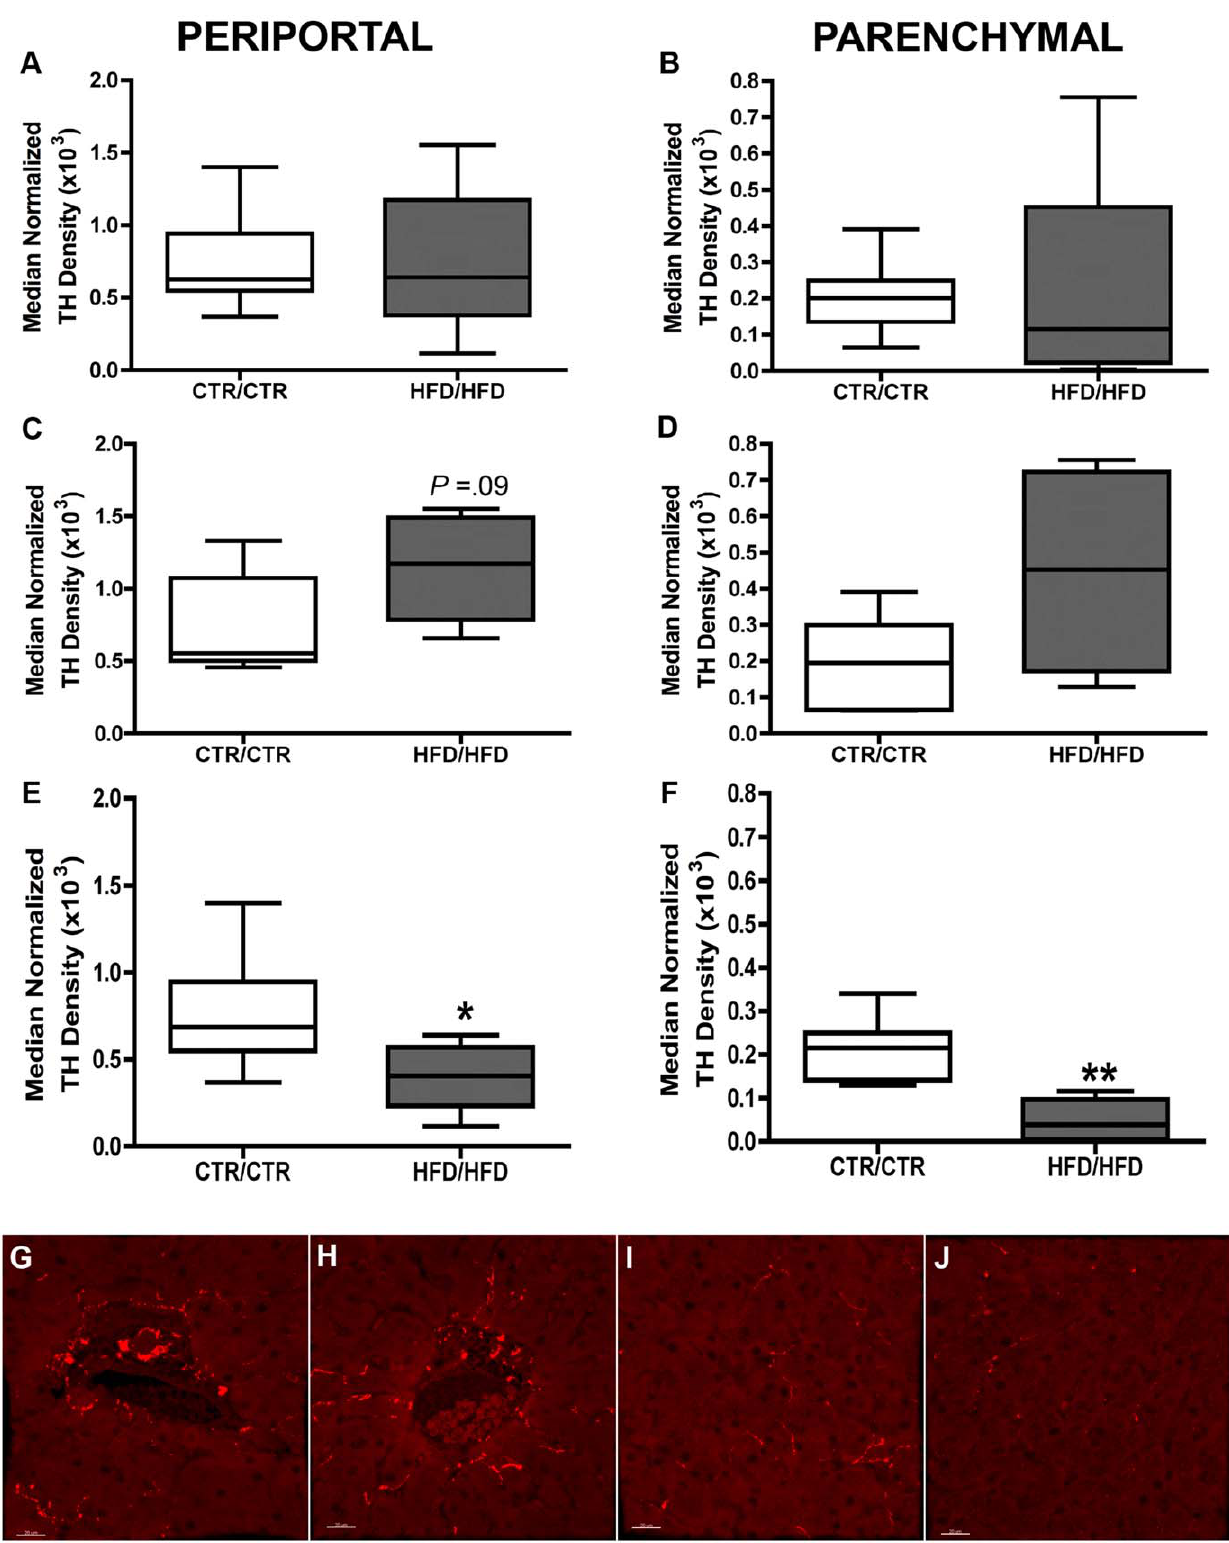
Figure 4. Quantification of the density of TH nerve fibers between CTR/CTR and HFD/HFD diet groups in the juvenile macaque liver. (A,C and E) Quantification of TH nerve fibers in the periportal region. (B,D and F) Quantification of TH nerve fibers in the hepatic parenchyma. TH immunofluorescence was acquired in each region by laser scanning confocal microscopy. The volume of TH immunoreactive fibers was normalized to the volume of hepatic tissue in each image. Data are expressed as the median normalized density for each juvenile diet group. (A-B) No differences were observed in the density of sympathetic innervation in juvenile liver between diet groups. CTR/CTR; n=12, HFD/HFD; n=9. (C-D)